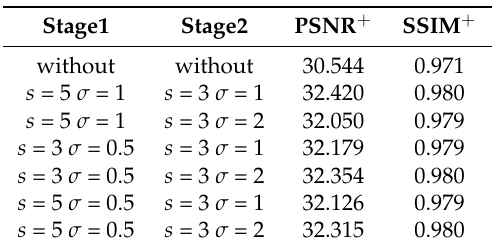
Figure 1. Comparison of inpainting effects at stage1 and stage 2 with different parameters. Table 2. Performance comparison of two-stage loss function using Gaussian convolution kernel with different parameters at different